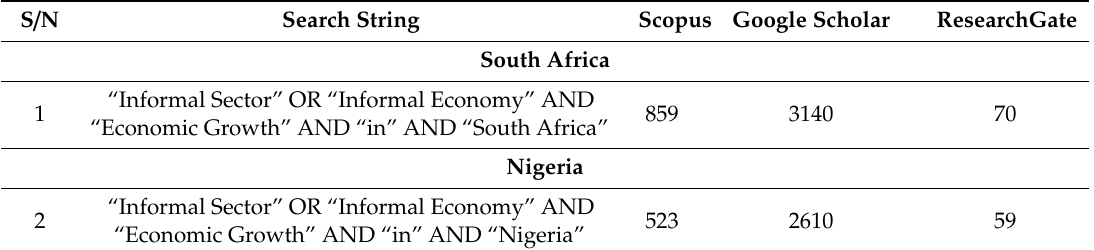
Table 7. Search strings and